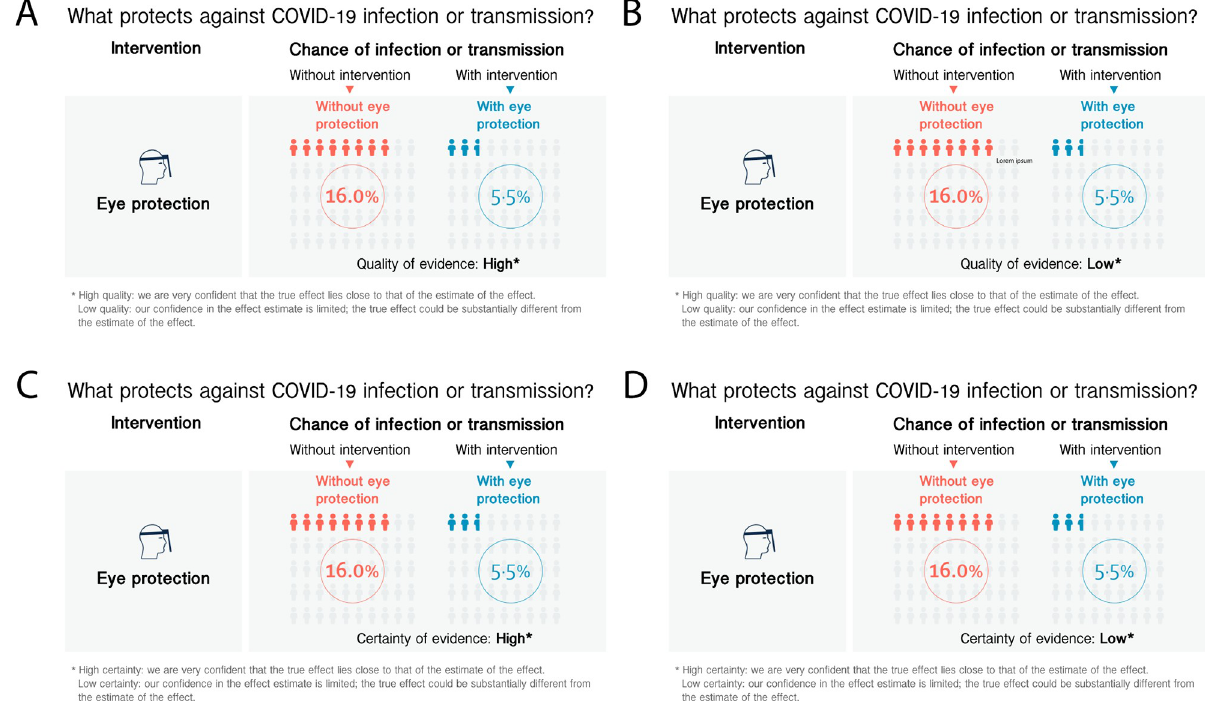
Fig 1. Infographics used in Experiment 1 showing the chance of infection or transmission of COVID-19 without and with eye protection along with information on the underlying certainty/quality of evidence levels. The four panels are depicting the infographics used for the four experimental conditions. (A) infographic shown to participants in the High Quality of evidence condition, (B) infographic shown to participants in the Low Quality of Evidence condition, (C) infographic shown to participants in the High Certainty of Evidence condition, (D) infographic shown to participants in the Low Certainty of Evidence